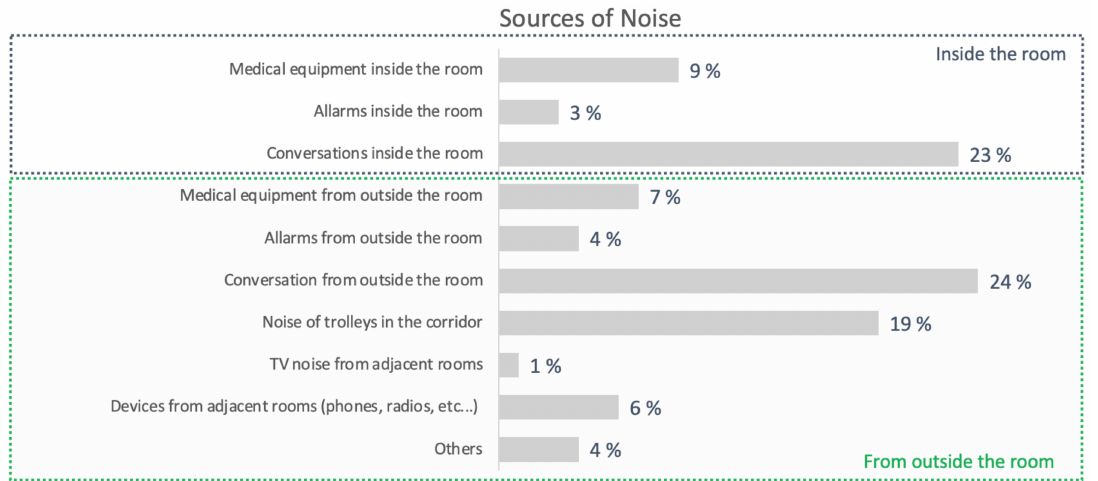
Figure 12. Results of the survey: “What sources of noise mainly woke you up during the